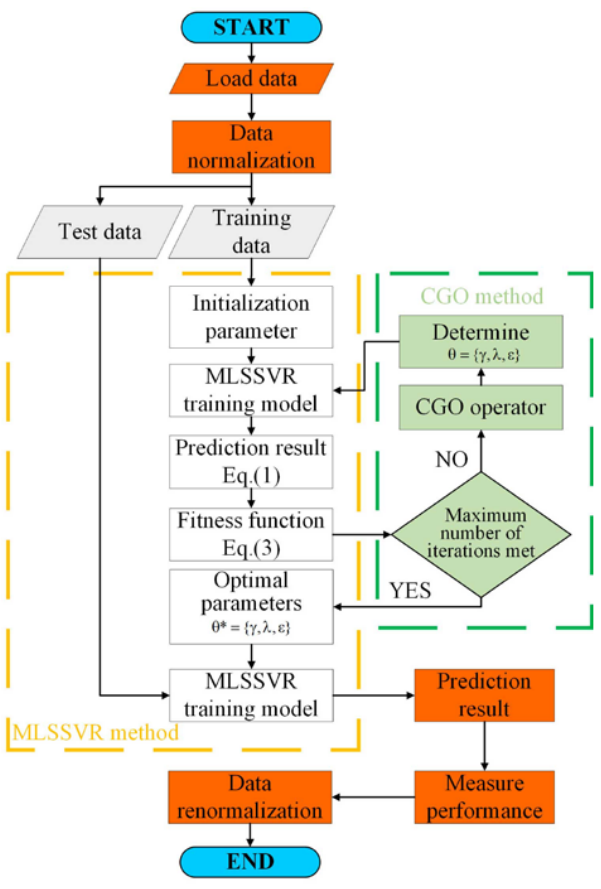
Figure 1. Flowchart of the CGO–MLSSVR algorithm.